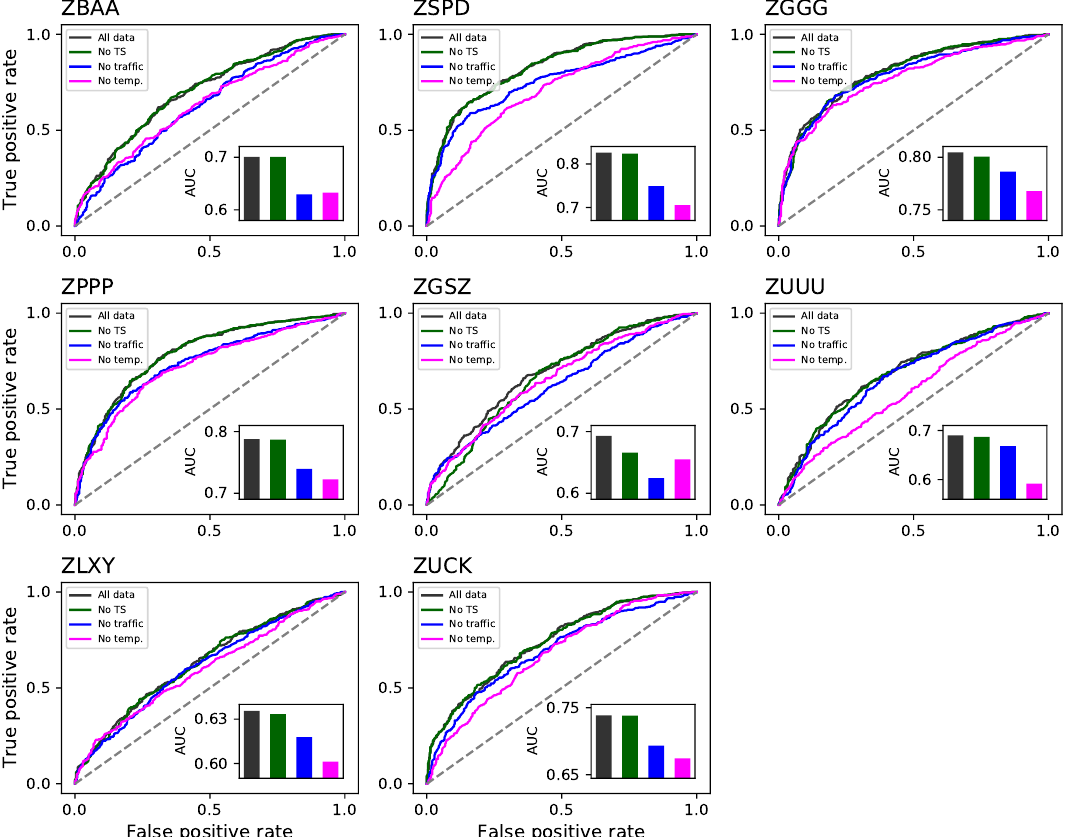
Figure 6. ROC curve of classification models predicting the level of binarized delays at each airport. All results correspond to Random Forest (RF) algorithms and a Leave-One-Out cross-validation strategy. The insets further depict the corresponding AUC for each classification model.